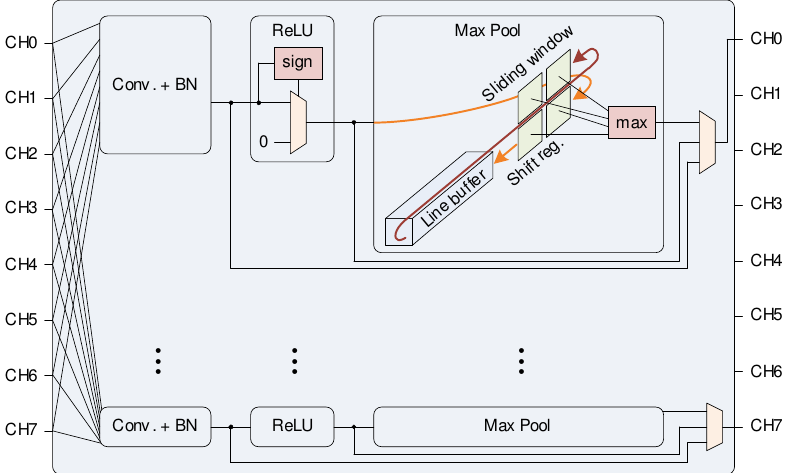
Figure 10. A core with 8 input and 8 output channels for convolution, batch normalization, ReLU, and max pooling